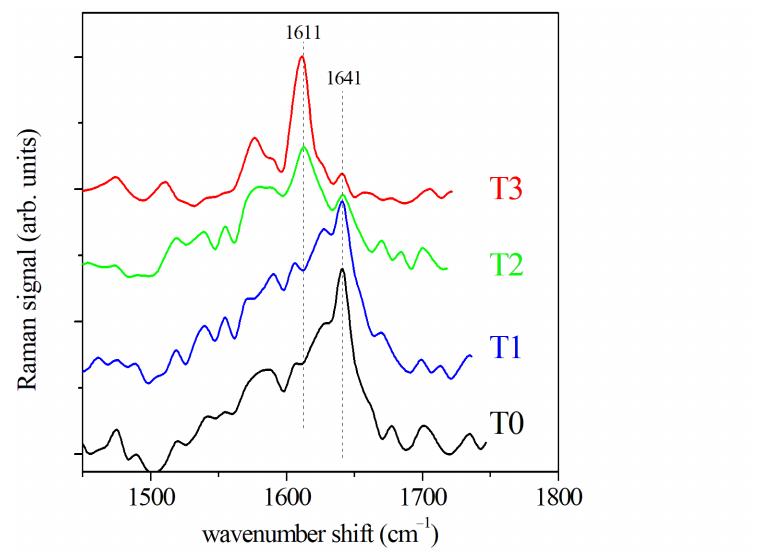
Figure 4. SERS spectra of GCF before OTM (T0) and at increasing OTM times, namely 2 days (T1), 7 days (T2), and 14 days (T3),